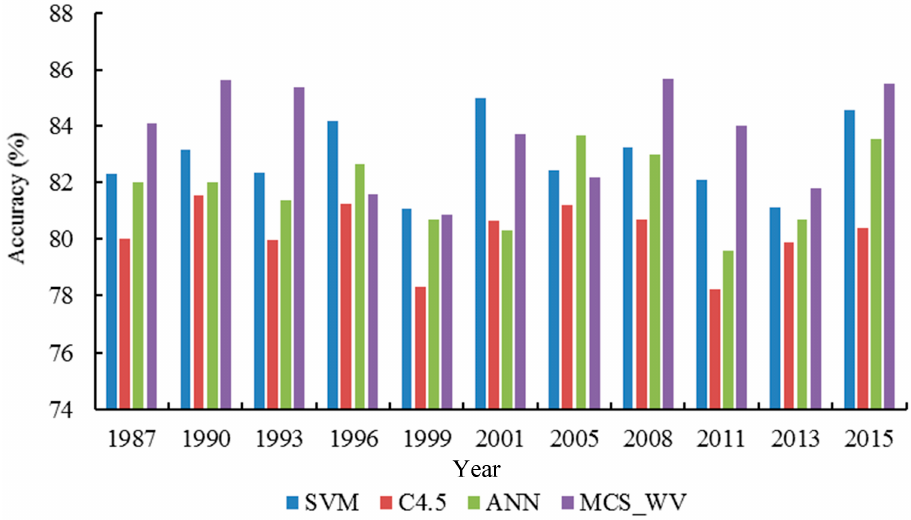
Figure 7. Overall classification accuracies by SVM, C4.5, ANN and MCS_WV for different years.